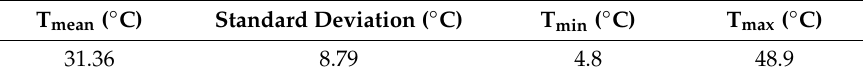
Table 4. Summary of thermal